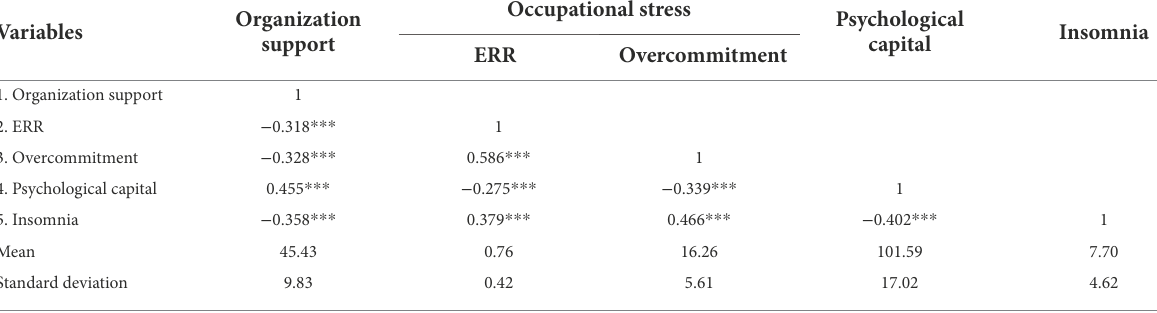
TABLE 2 Correlation analysis of perceived organization support, psychological capital, occupational stress, and insomnia.